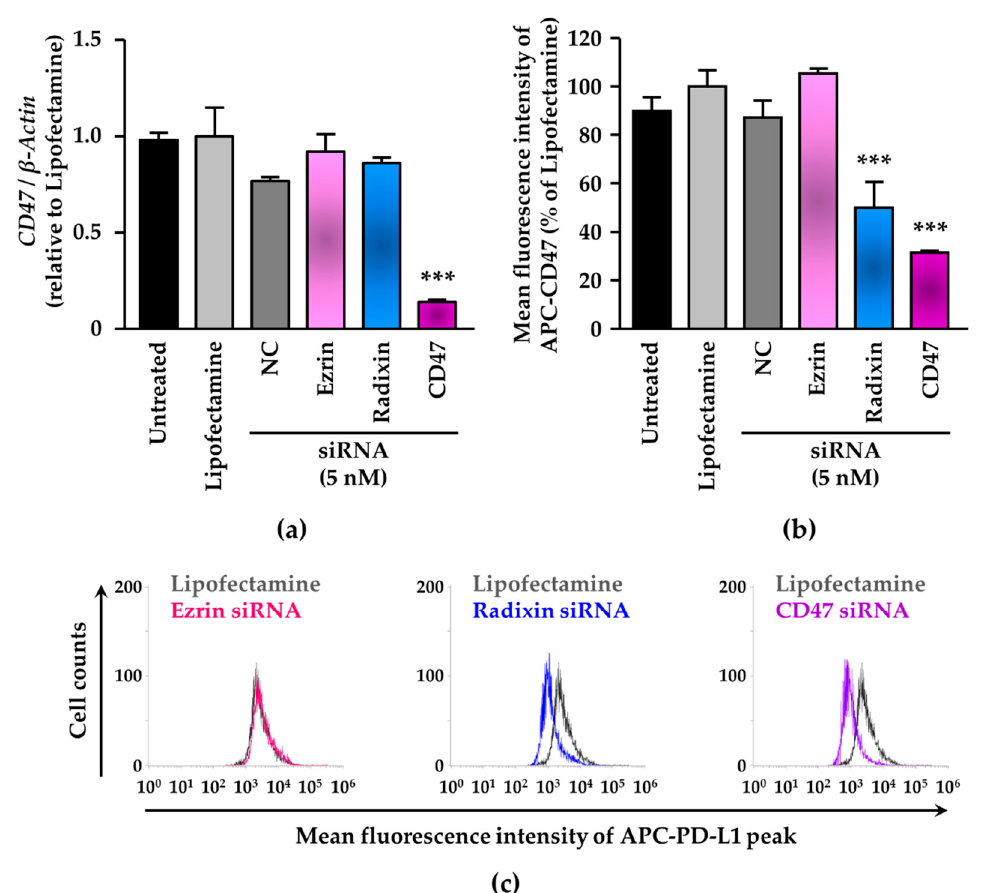
Figure 4. siRNA-mediated knockdown of radixin decreased cell surface expression levels of CD47 in KP-2 cells. ( a ) CD47 mRNA expression levels normalized to β -Actin in each treatment cell relative to that in Lipofectamine-treated cells; n = 3, *** p < 0.001 vs. Lipofectamine. ( b ) Mean fluorescence intensity of allophycocyanin (APC)-labeled CD47 on the cell surface membrane in all treatment groups relative to that in Lipofectamine alone; n = 3, *** p < 0.001 vs. Lipofectamine. ( c ) Flow cytometric histograms of the mean fluorescence intensity for APC-labeled CD47.